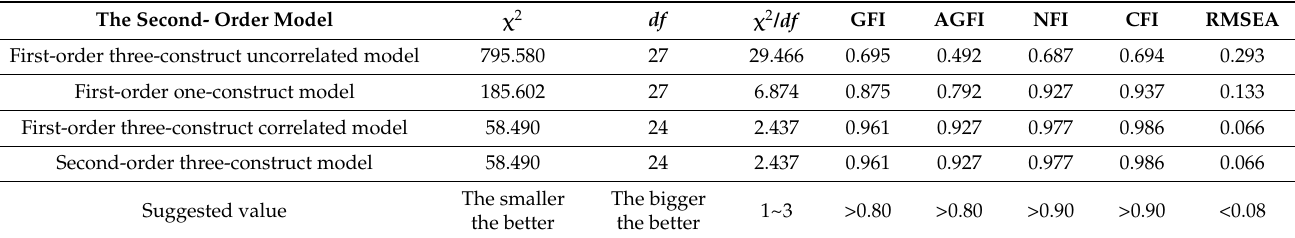
Table 9. Comparison of the results of different